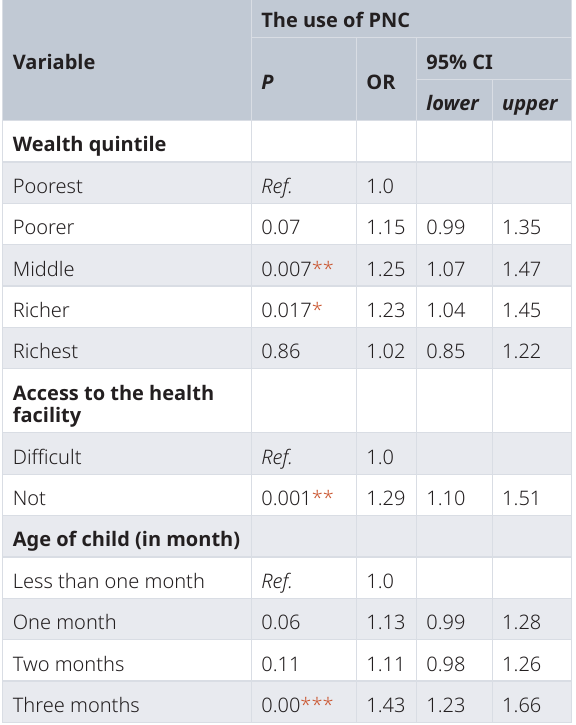
Table 5. Binary logistic regression of PNC utilisation among mothers aged 15–49 years old in